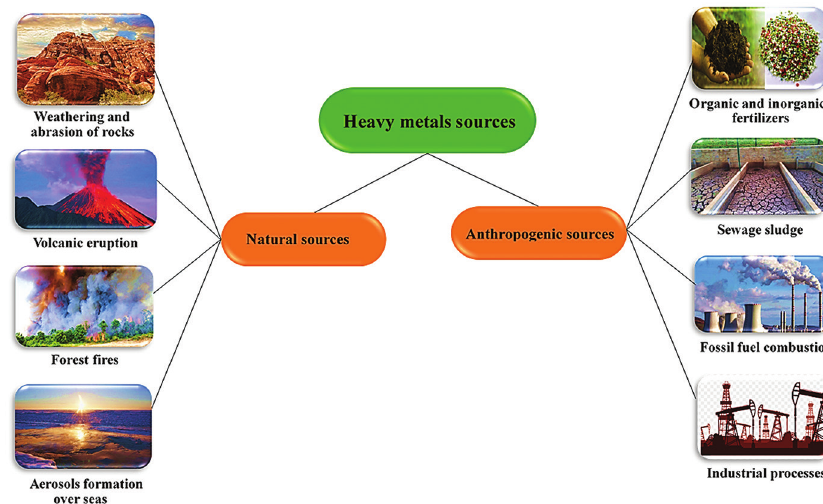
Figure 1: Sources of heavy metals in